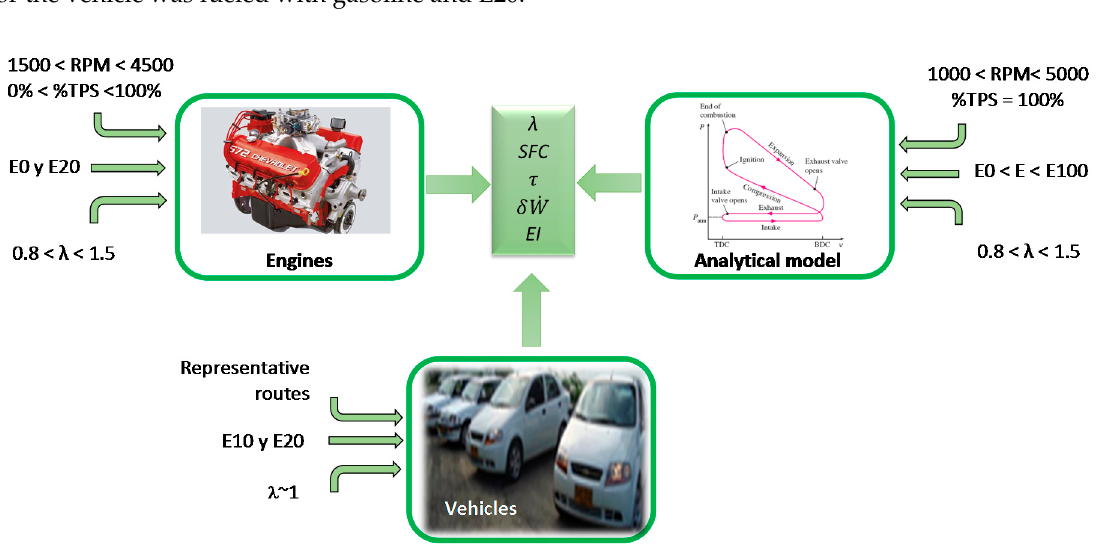
Figure 1. Illustration of the general methodology used to evaluate the effects of using ethanol-gasoline blends on the mechanical, energy and environmental performance of in-use vehicles during their useful life of operation.